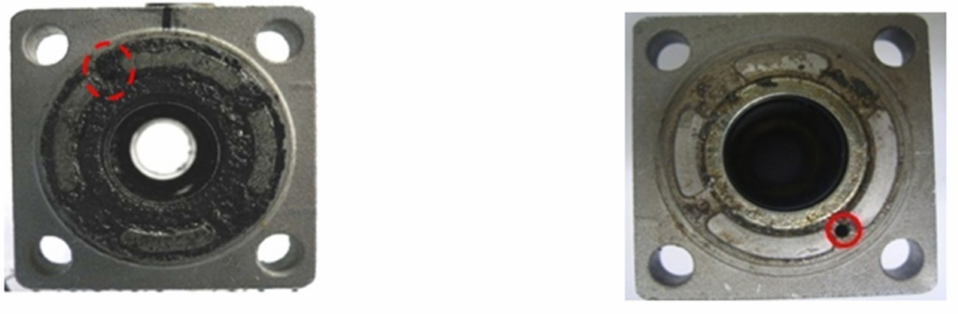
Figure 14. Blocked rod cap found parametric